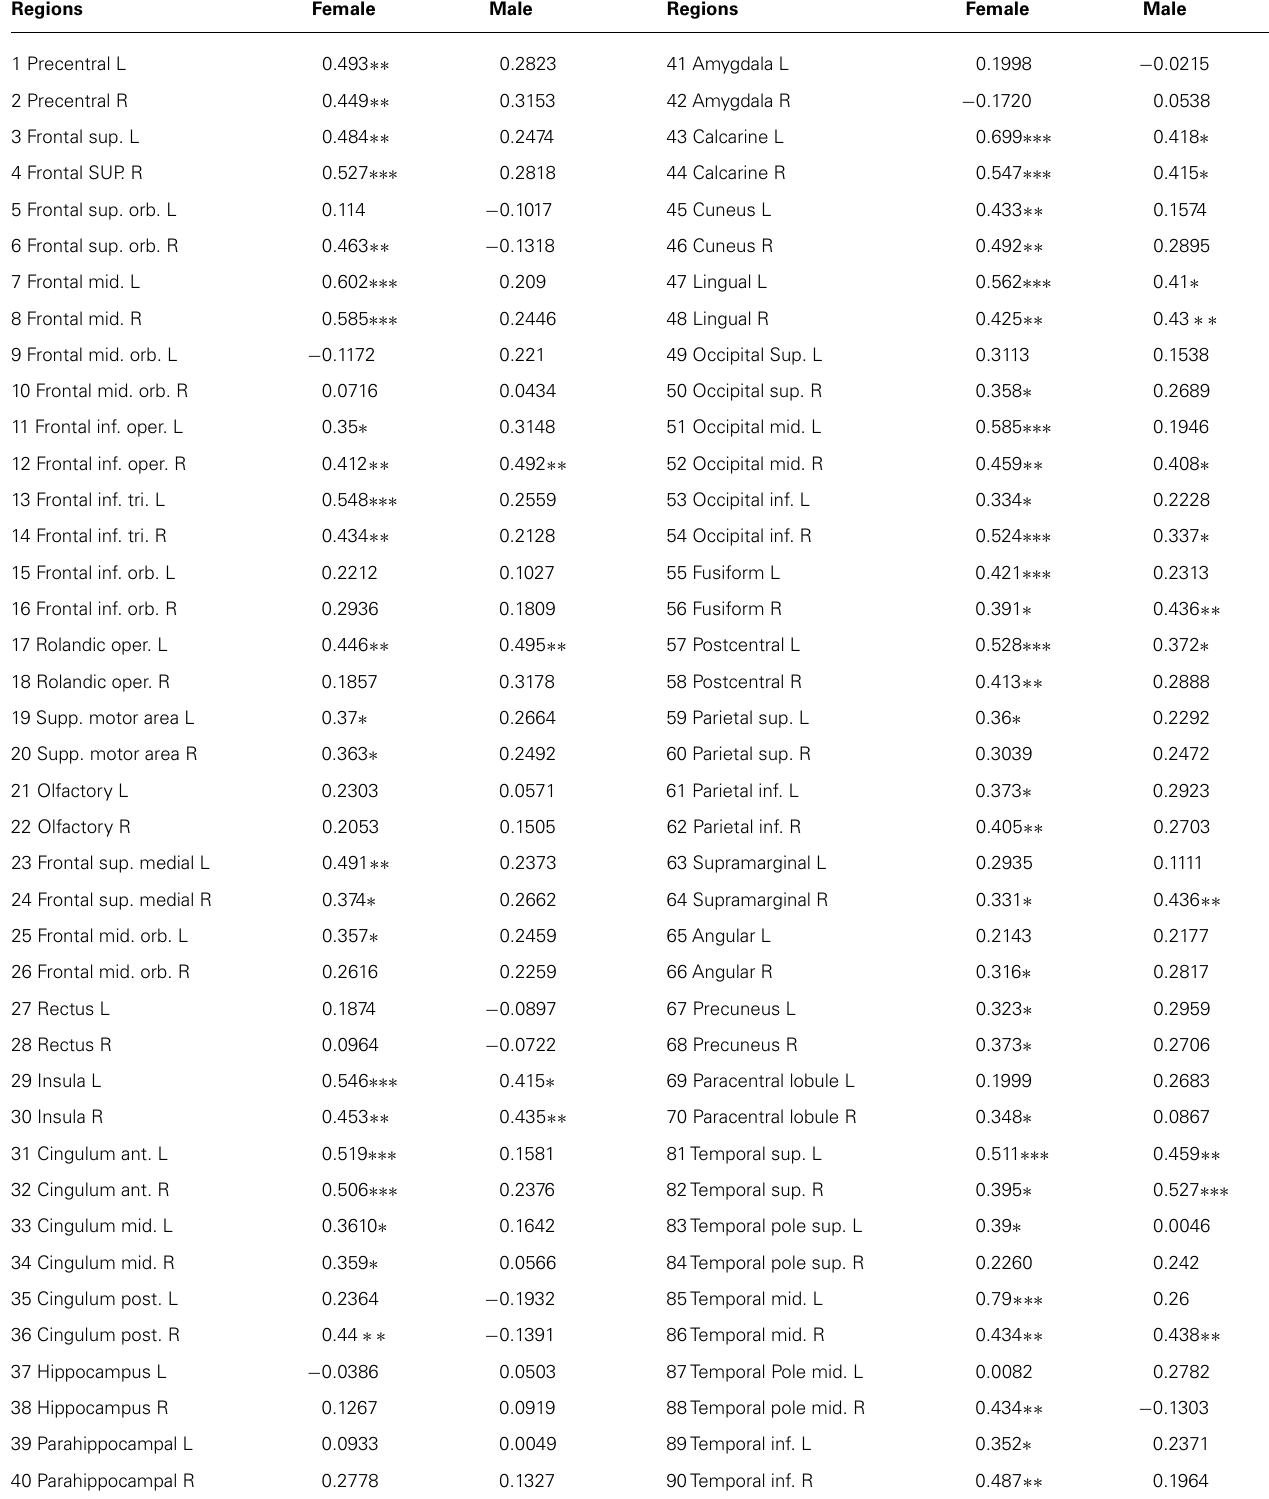
Table 1 | Pearson correlation coefficient from parcellated cortical regions between mean diffusivity and age for each sex. Regions